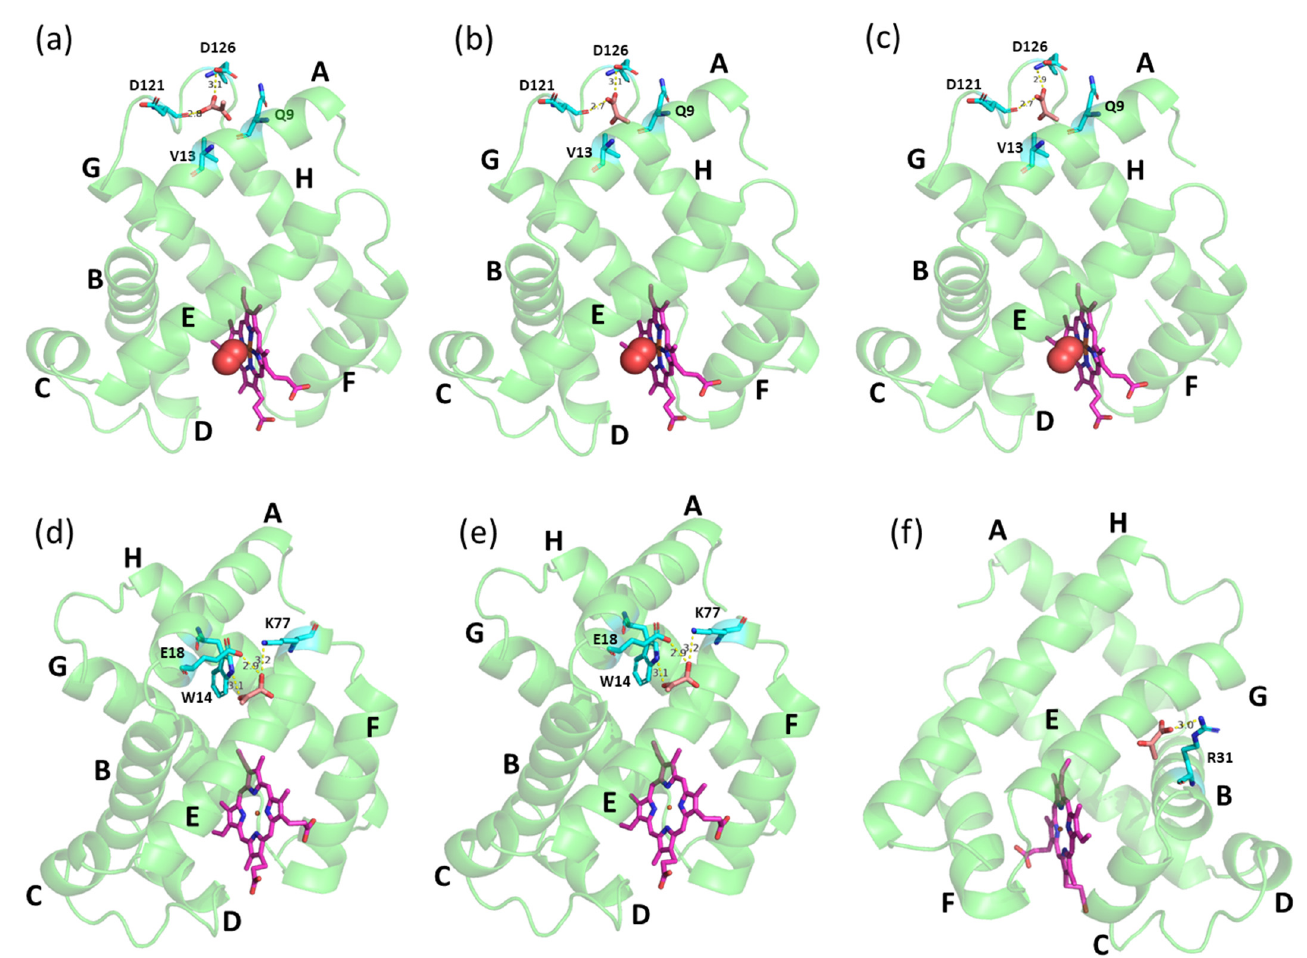
Figure 4. Docking structures of PYR binding with equine skeletal muscle Mb. Top row displays oxy-Mb at ( a ) pH 7.0, ( b ) pH 6.4 and ( c ) pH 6.0, and bottom row displays deoxy-Mb at ( d ) pH 7.0, ( e ) pH 6.4 and ( f ) pH 6.0, respectively. PYR (brown), heme center (pink), and the amino acid residues (cyan) interacting with PYR are displayed as sticks. Mb protein (green) is displayed as ribbon structure an oxygen (red) in spheres. Possible hydrogen bond interactions between side chains of residues and PYR are displayed as dashed yellow lines with bond length in angstroms.